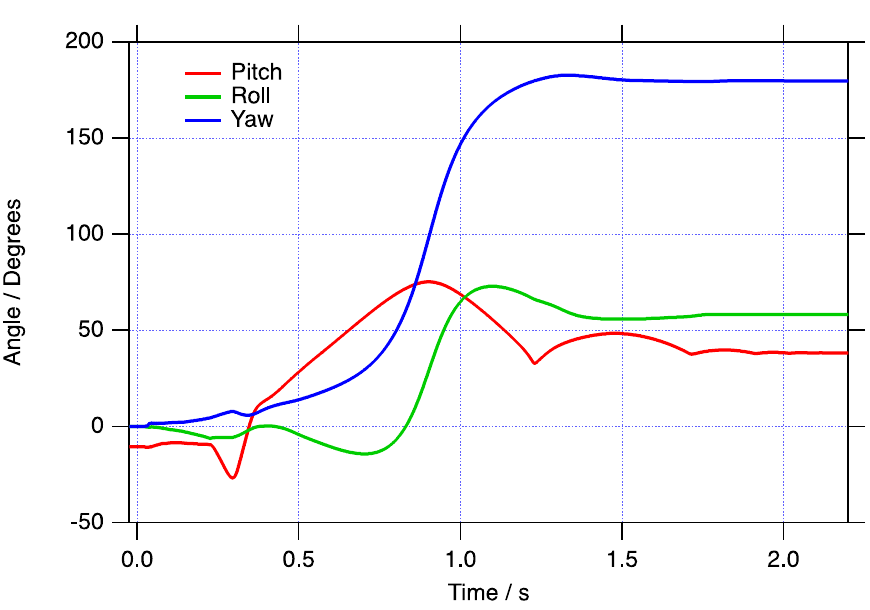
Figure 3. The roll, pitch, and yaw of the blast loaded object as a function of time. The object had an initial nose down pitch of 10.5° in the earth’s FOR.